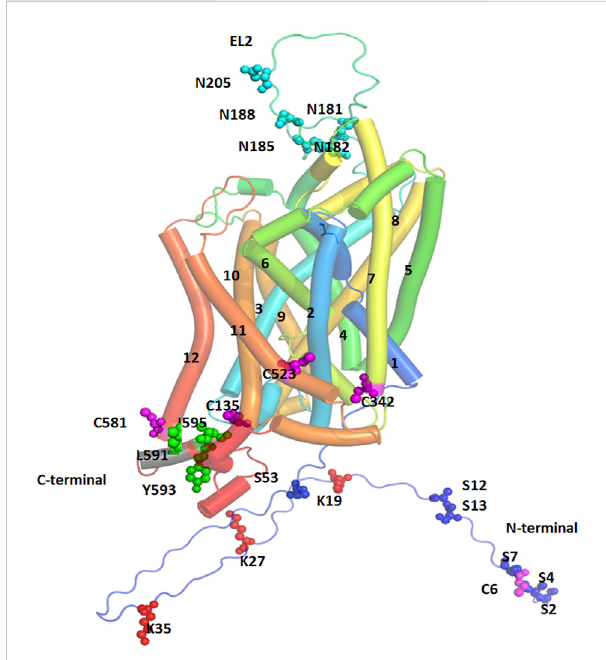
FIGURE 3 Post-Translational Modi fi cation (PTM) sites for hDAT are depicted. TM helices are labeled, and color coded. The sites of PTM are shown in spherical models and are color coded. Magenta spheres represent sites for palmitoylation, red spheres represent ubiquitinationsites,cyanspheresrepresentsitesforglycosylation, and green spheres represent the site for PKC-mediated